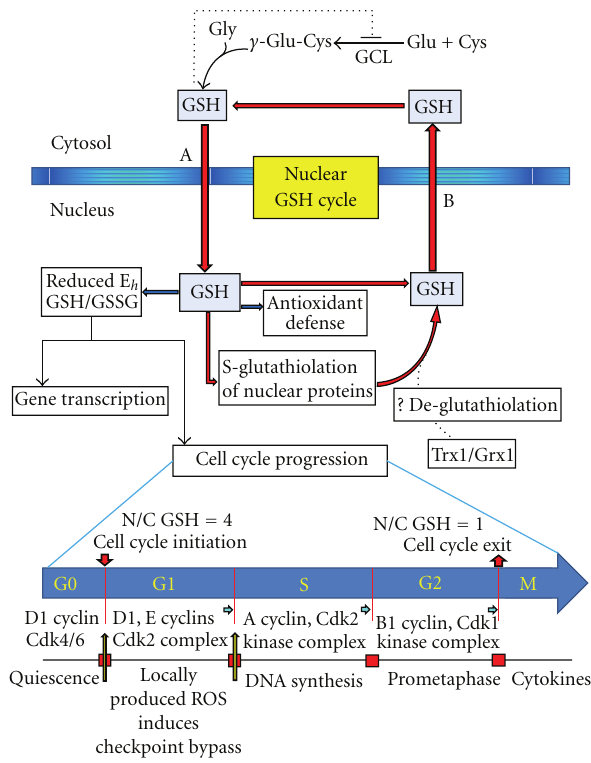
Figure 2: Nuclear glutathione cycle and associated redox changes during cell cycle progression . A nuclear GSH cycle is established during cell cycle progression that involves the dynamic partitioning of cellular GSH between the nuclear and cytosolic compartments. Cell entry into the cycle in early G 1 is associated with sequestration of GSH into the nucleus (A). At this stage of cell cycle initiation, the nuclear- to-cytosol (n/c) GSH ratio approximates 4. The transient decrease in cytosolic GSH releases feed-back inhibitory e ff ect of GSH on GCL activity and triggers de novo GSH synthesis, a process that continues until the feedback control is reestablished. Sequestered intranuclear GSH exists in the reduced form or bound to nuclear proteins, which together changes the GSH/GSSG redox potential ( E h ) in favor of gene transcription and cell cycle-associated DNA synthesis/replication. Free GSH functions in antioxidant defense that protects against oxidative DNA damage during DNA replication. As yet unclear, free GSH may be regenerated via deglutathiolation of thiolated nuclear proteins, likely catalyzed by Trx1 and/or Grx1. The dissolution of the nuclear envelope in the prometaphase and cytokinesis (cell cycle exit) induces nuclear-to-cytosol GSH export (B) resulting in equal GSH distribution (n/c = 1) in the two compartments in the newly divided cells. Redox- dependent activation of regulatory checkpoints governs cell exit from quiescence (cyclin D1 and associated Cdk4), entry into and progression through cell cycle (cyclin E1-Cdk2, cyclin A-Cdk2 kinase complexes), and final exit from cell cycle (cyclin B1-Cdk1 kinase complex) (blue arrows). Additionally the checkpoints at the G 0 /G 1 or G 1 -to-S transitions can be bypassed by locally generated ROS (yellow arrows). GSH: glutathione, GSSG: glutathione disulfide, GCL: γ -glutamate cysteine ligase; n/c: nuclear-to-cytosol, Trx1: thioredoxin1, Grx1: